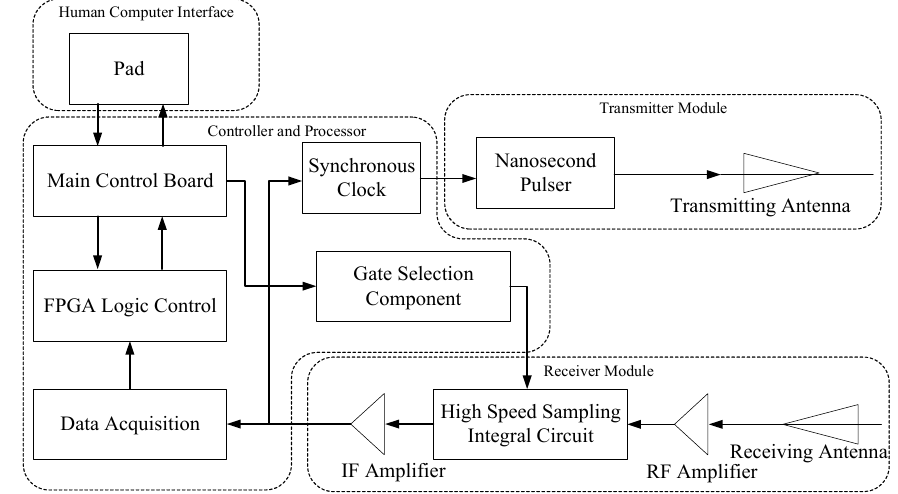
Figure 2. Hardware structure of the vital signs detection system.